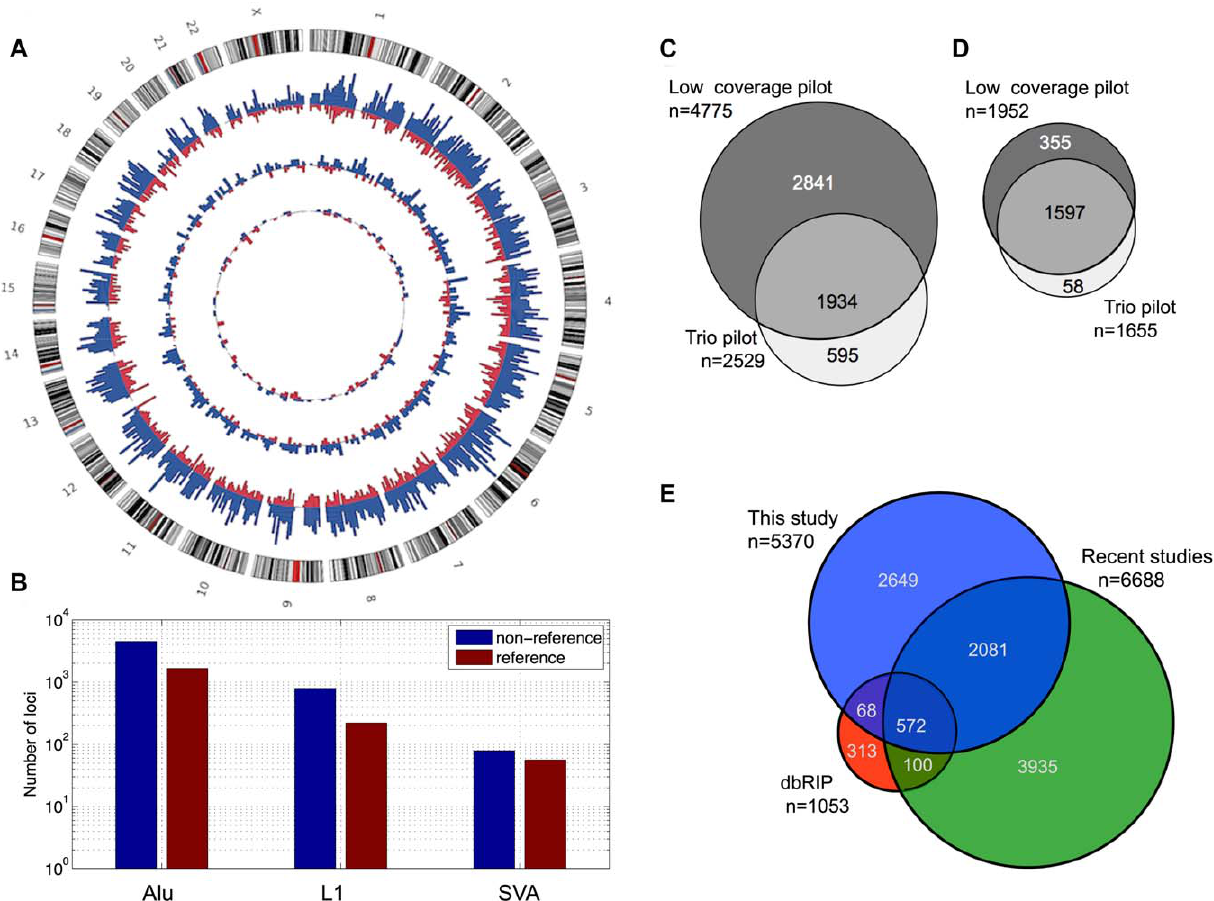
Figure 2. MEI catalog. a) MEI genomic distribution. Circos plot with non-reference MEI represented in blue and reference MEI in red. The outermost ring of chromosomes show the cytoband structure. The outer histogram displays counts of Alu polymorphisms in bins of 5 Mbp, the middle ring L1 polymorphisms in bins of 10 Mbp, and the innermost ring SVA polymorphisms in bins of 20 Mbp. The radial scale of the site counts is the same for each element type. b) MEI family breakdown. Non-reference MEI (blue) and reference MEI (red). c) Venn diagram of non-reference MEI from each pilot dataset. Most of the loci were detected from the low coverage dataset (dark grey). d) Venn diagram of reference MEI from each pilot dataset. e) Venn diagram of non-reference MEI from this study and other studies